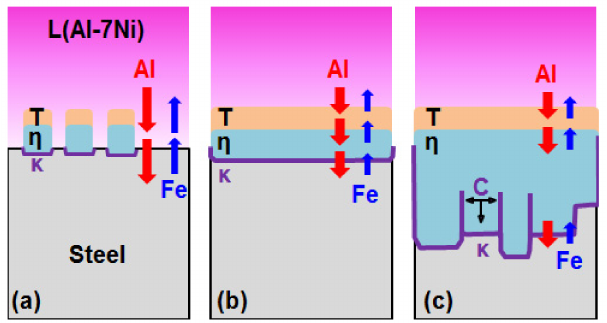
Figure 16. Formation mechanism of the reaction layer formed by the dissolution and interdiffusion reactions during the hot-dipping process.